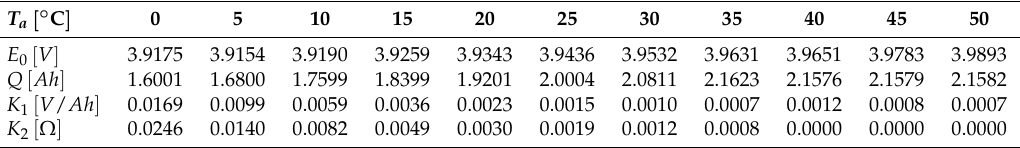
Table 4. Estimated battery parameters at different temperatures during